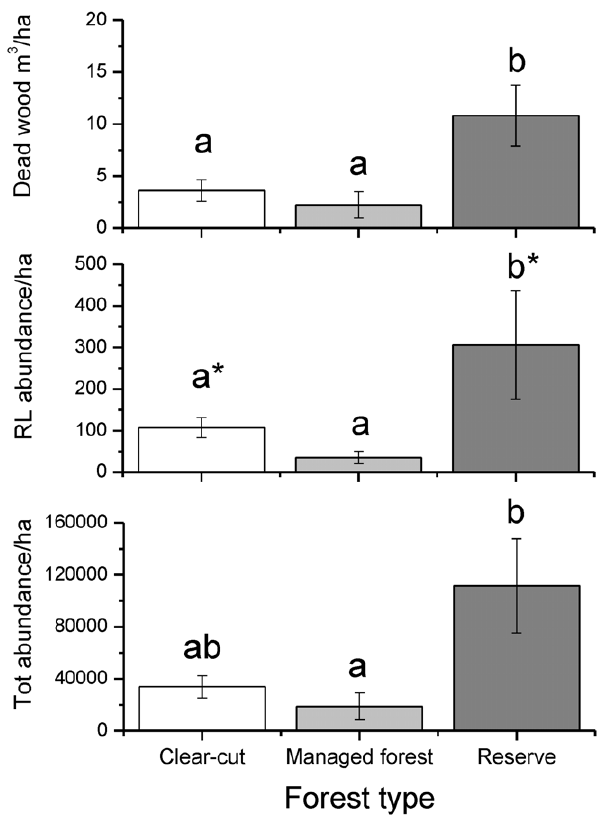
Figure 4. Dead wood volume and abundances/ha. The abun- dance of dead wood per ha in decomposition class DC1 and the calculated estimated number of individuals produced of red-listed (RL) species and all saproxylic species per ha in the three different forest types. Abbreviations: CC=Clear-cuts, MF=Mature managed forests, R=Reserves. Bars with different letters denote statistically significant effects (Quade multiple comparison test, p , 0.05, * p =0.098). Vertical bars shows 6 1